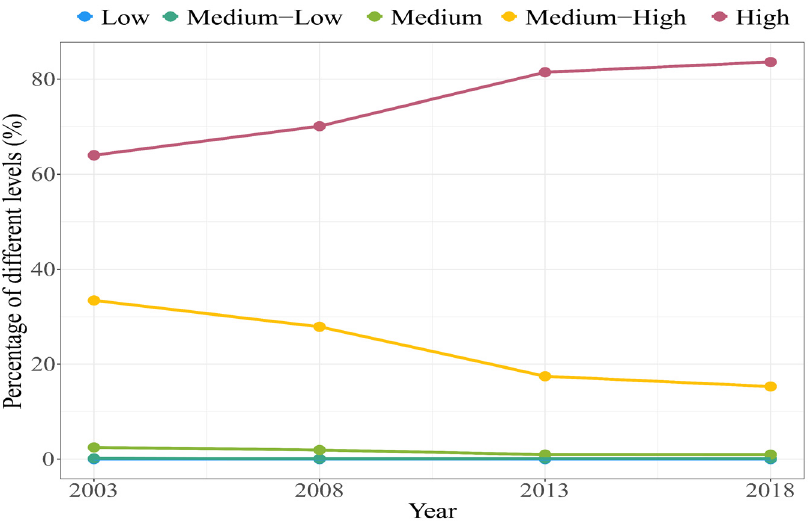
Figure 6. Percentage of different levels of NDVI in the QBM, 2003–2018.